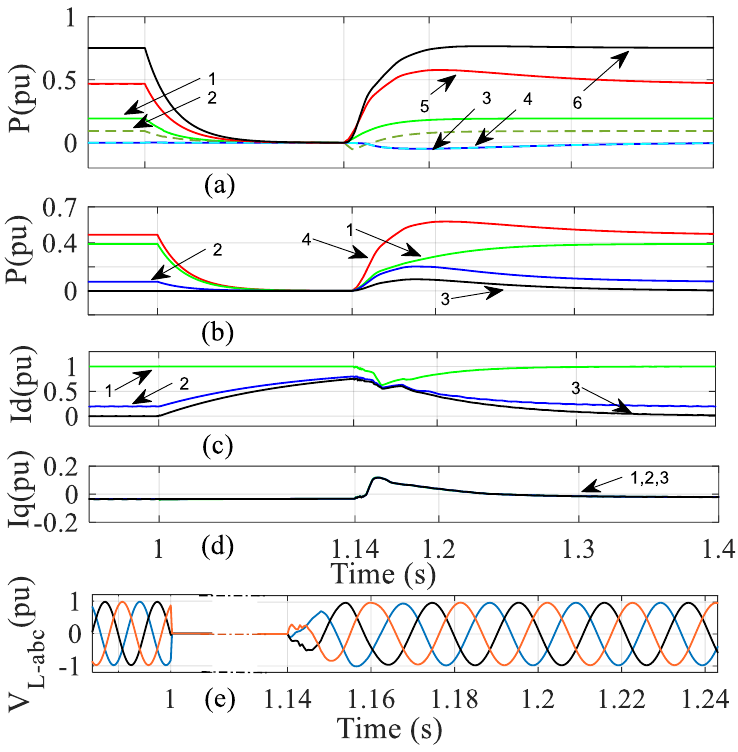
Figure 8. Three-phase fault. ( a ) Power (pu), 1 — P pv 1 ; 2 — P pv 2 ; 3 — P b 1 ; 4 — P b 2 ; 5 — P g ; 6 — P L . ( b ) Power from MGSCs (pu), 1 — P g 1 ; 2 — P g 2 ; 3 — P g 3 ; 4 — P g . ( c ) d -components of MGSC currents (pu), 1 — I d-g 1 ;